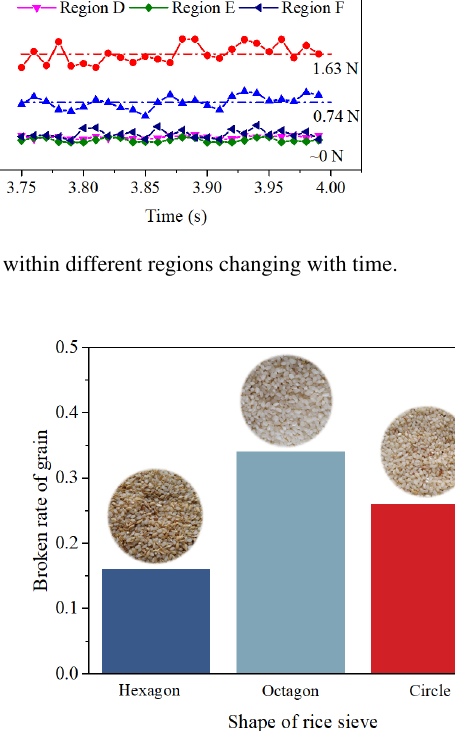
Figure 6. The milled rice grains and their broken rates under dif- ferent shapes of the rice